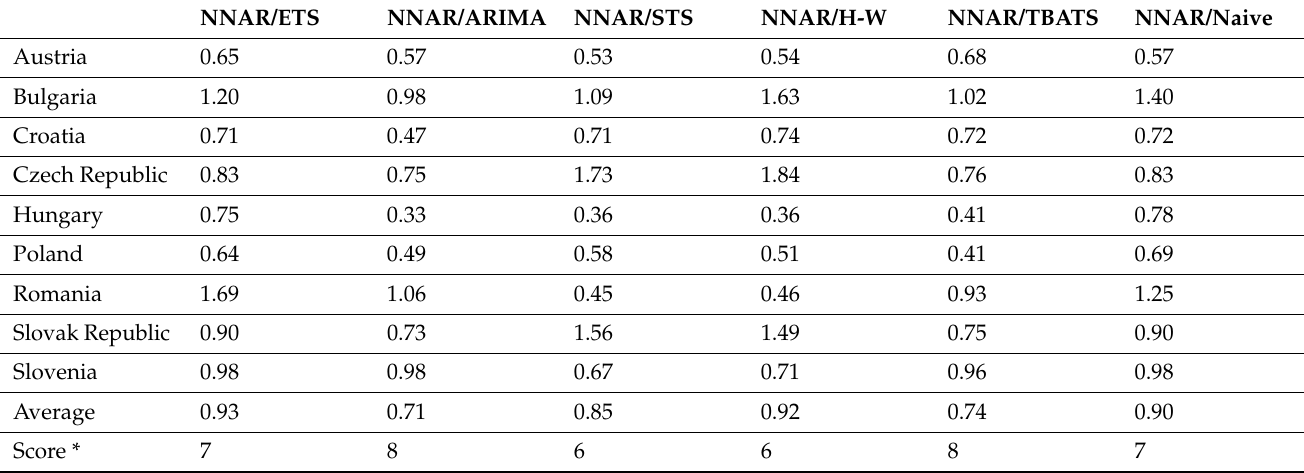
Table 3. The relative root mean squared error (RRMSE) for the forecasting horizon h = 8. NNAR/ETS